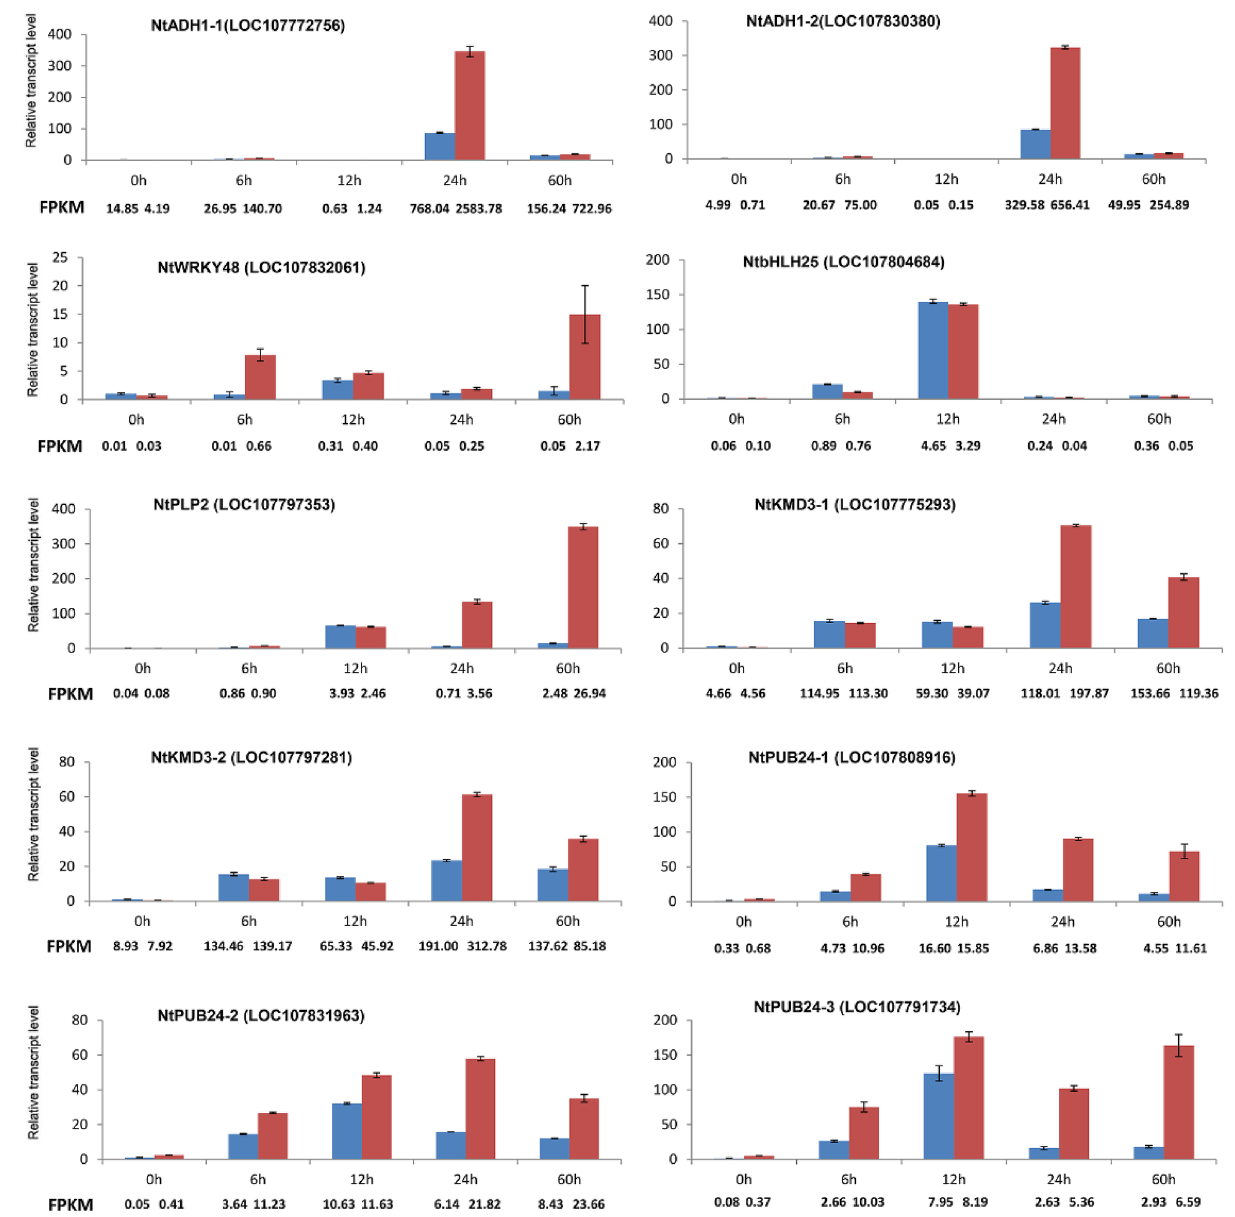
Figure 8. The relative expression levels of identified susceptible genes at each time point after P. nicotianae inoculation in BH and XHJ. Blue bars indicate BH, whereas red bars indicate XHJ. Actin was used as an internal control, and the transcript level in non-infected plants was set as 1.0. Error bars represent standard error ( n =